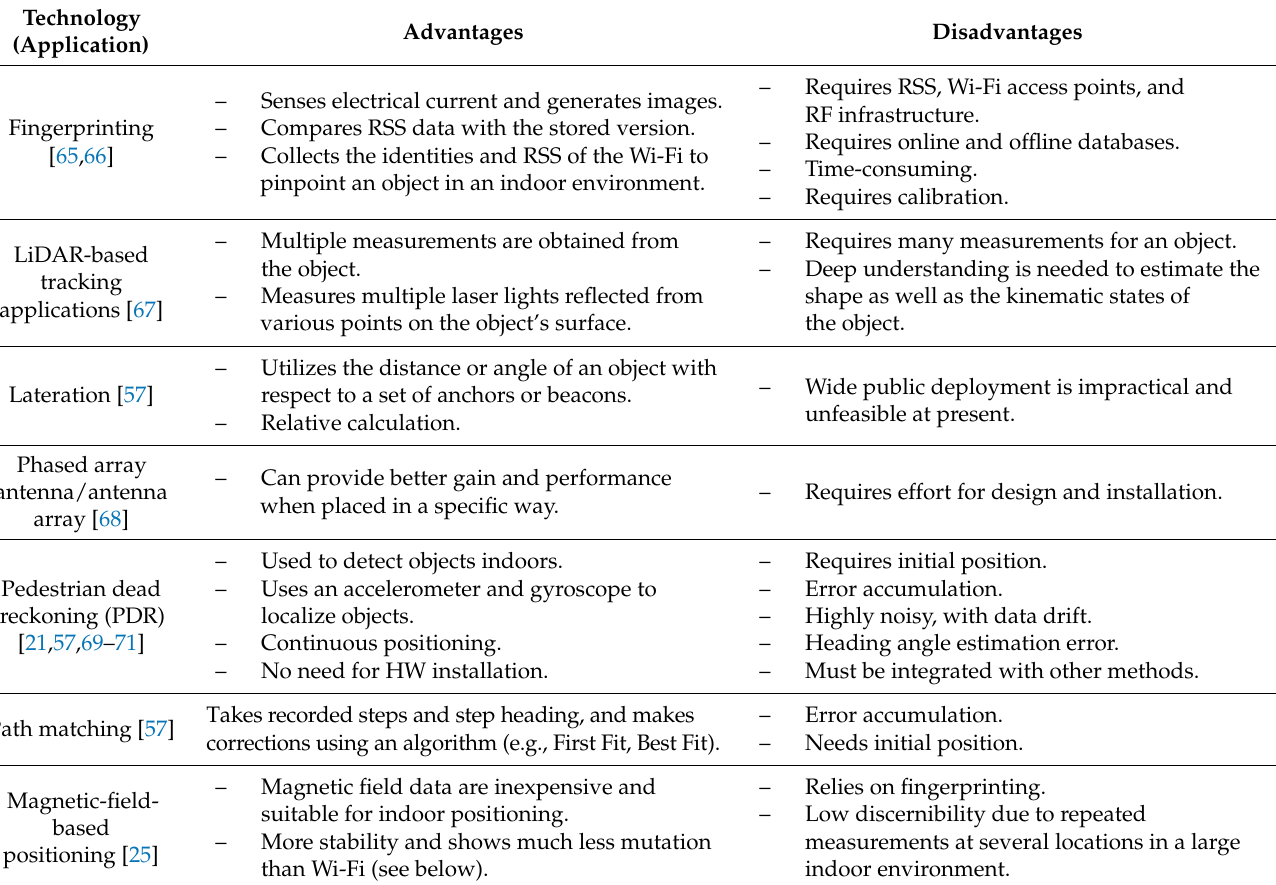
Table 3. Most relevant indoor navigation techniques in the